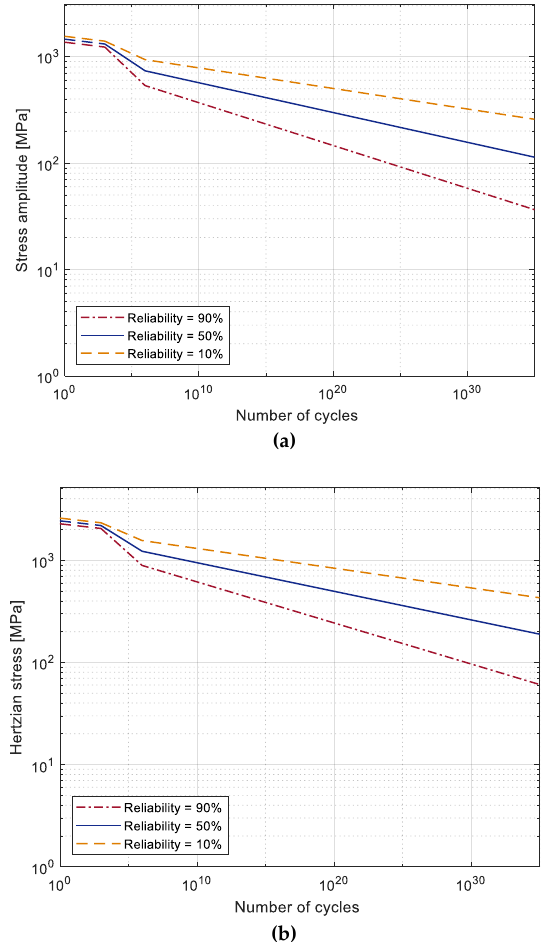
Figure 14. The fatigue curve for the recirculating mechanism: ( a ) the fatigue curve in terms of alternating stress and ( b ) the fatigue curve in terms of pressure.